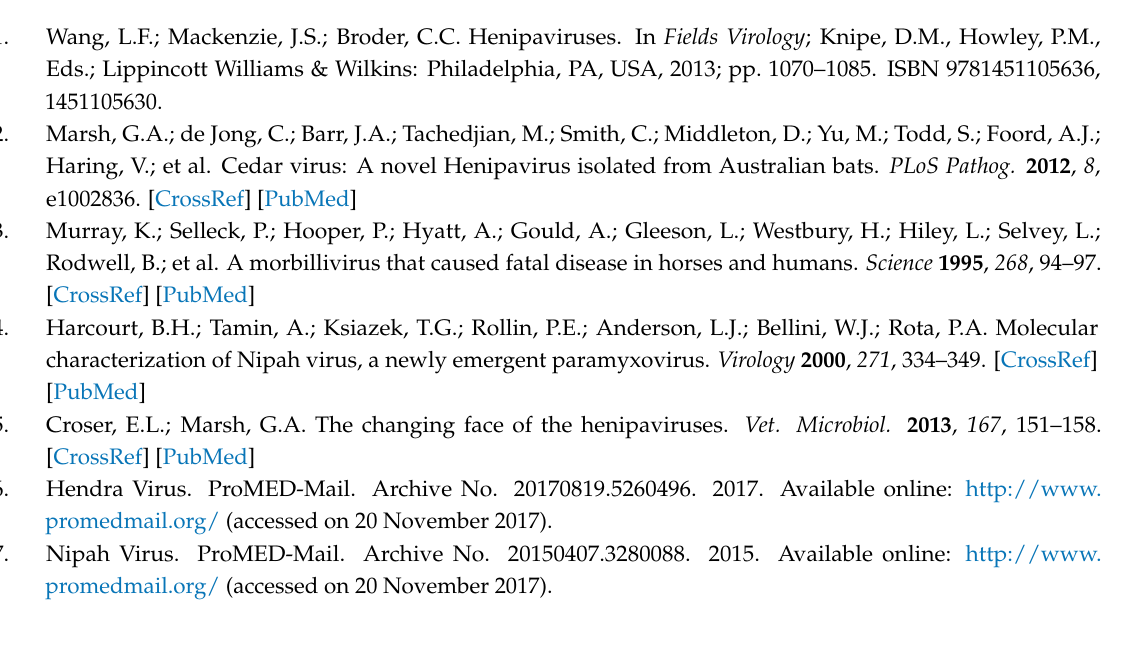
Supplementary Materials: The following are available online at http://www.mdpi.com/1999-4915/10/11/604/ s1, Figure S1: PR-2 plots for the entire coding sequences of HeV and NiV isolates, Figure S2: A comparison of relative CpG frequencies of Malaysia and Bangladesh NiV isolates, Table S1: The demographics of HeV and NiV isolates used in this study, Table S2: The nucleotide compositions analyses of HeV and NiV isolates used in this study, Table S3: Correlation analyses among the nucleotide compositions and other parameters of NiV and HeV coding sequences, Table S4: Neutrality plots for entire coding sequences of NiV and HeV isolates, Table S5: The CAI values of different protein coding sequences of HeV and NiV in relation to various hosts, Table S6: The tRNA adaptation index for NiV